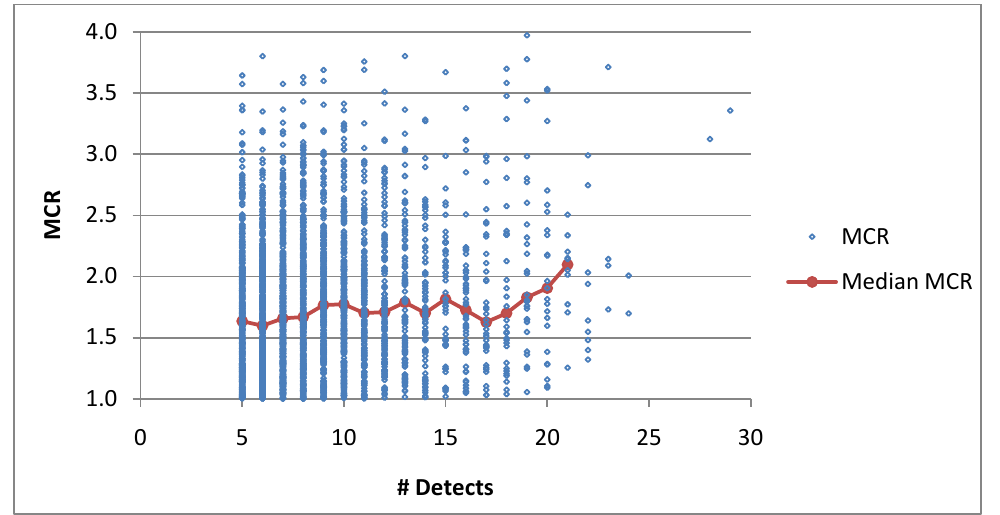
Figure 4. The relationship between MCR and n for Case 1. MCR and n have a weakly positive correlation, Kendall’s tau-b value of 0.08 (p < 0.0001) based on all samples and Kendall tau-b value of 0.55 (p < 0.01) for medians of grouped samples.